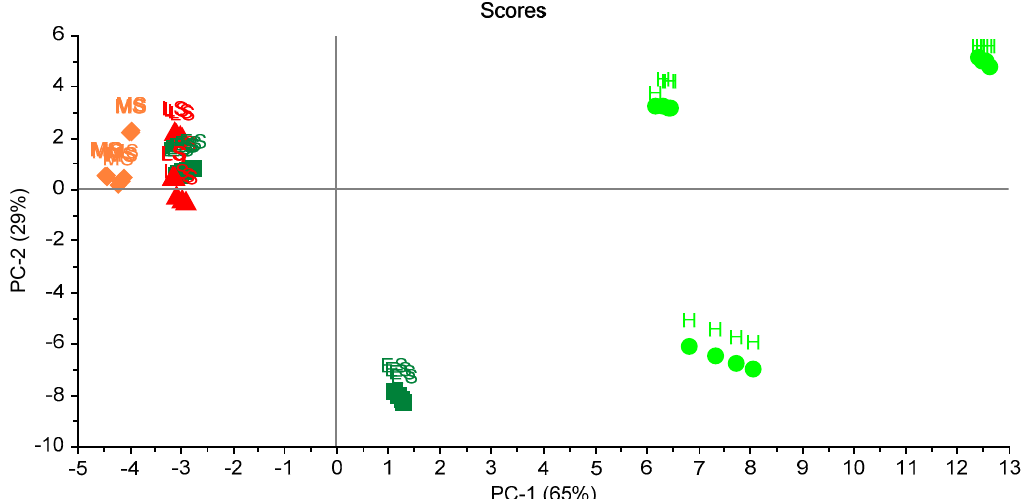
Figure 9. Scores plot of the samples in the third trial of measurements. A clear separation between samples is shown. Healthy sample (H), infected early-stage (ES), infected moderate-stage (MS), and infected late-stage (LS).